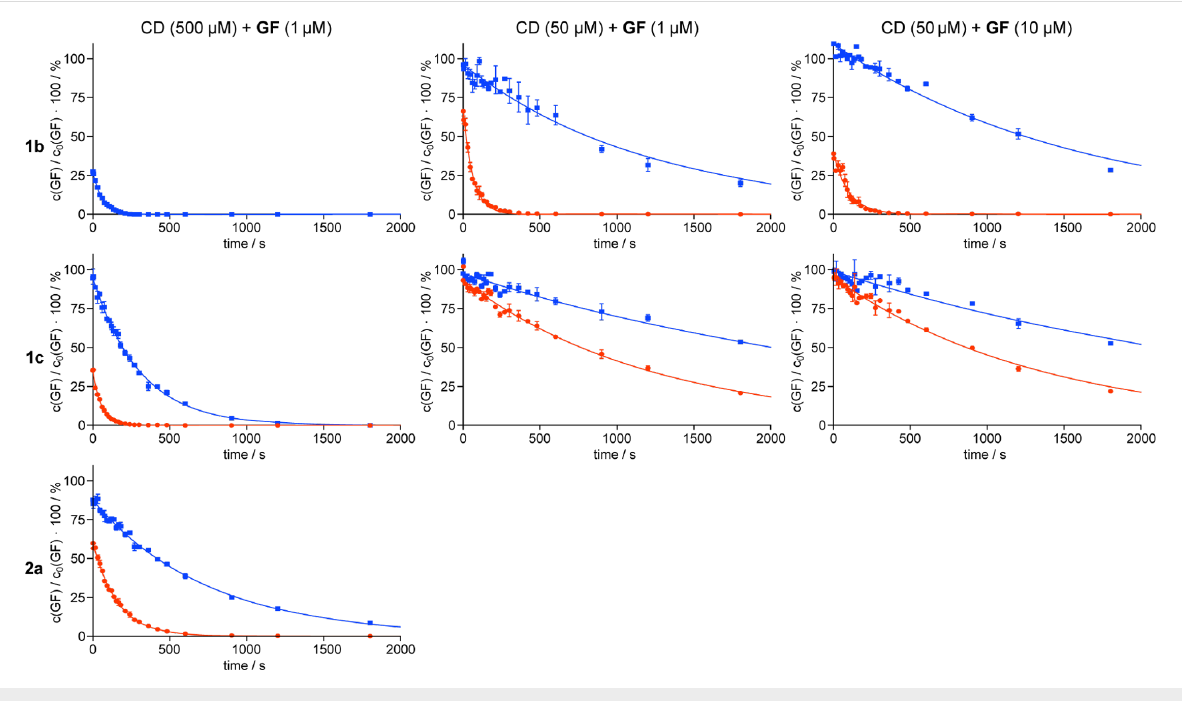
Figure 3: Time-dependent decrease of GF concentration in the presence of 1b (top row), 1c (middle row), and 2a (bottom row). The measurements were performed at different concentrations of cyclodextrin (CD) and nerve agent, which are indicated at the top of each column. The data points (means ± SD, n = 2) denote the experimental results normalized to the initial concentration of GF , c 0 ( GF ). The curves show the results of fitting the data points to a first-order rate reaction. Disappearance of the ( − )-enantiomer of GF is shown in red and that of the (+)-enantiomer in